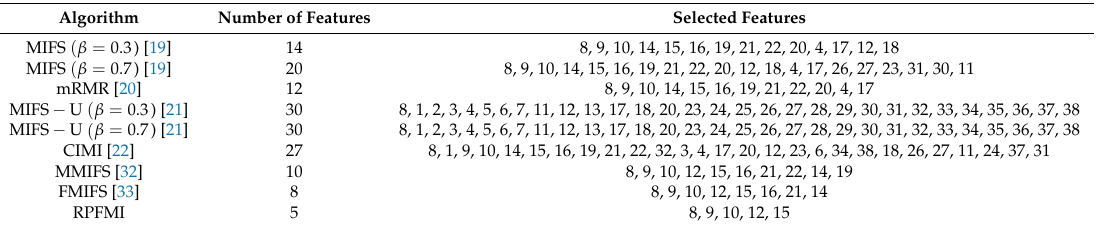
Table 9. Features selected by different feature selection algorithms using the R2L classifier. Algorithm Number of Features Selected Features